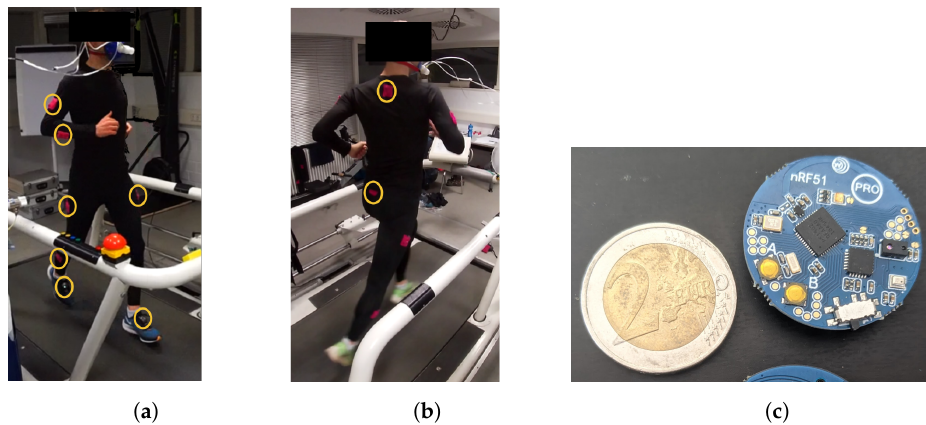
Figure 3. ( a , b ) Picture of sensor suit from front/back. Sensor Beacons are attached to the runner in pink sewn-on pockets (yellow circles) at 12 locations: 2 × feet, 2 × shin, 2 × thigh, 2 × upper arm, 2 × lower arm, hip, and neck. ( c ) Picture of the used Bluetooth beacon (weight = 6 g, diameter = 3 cm, coin for